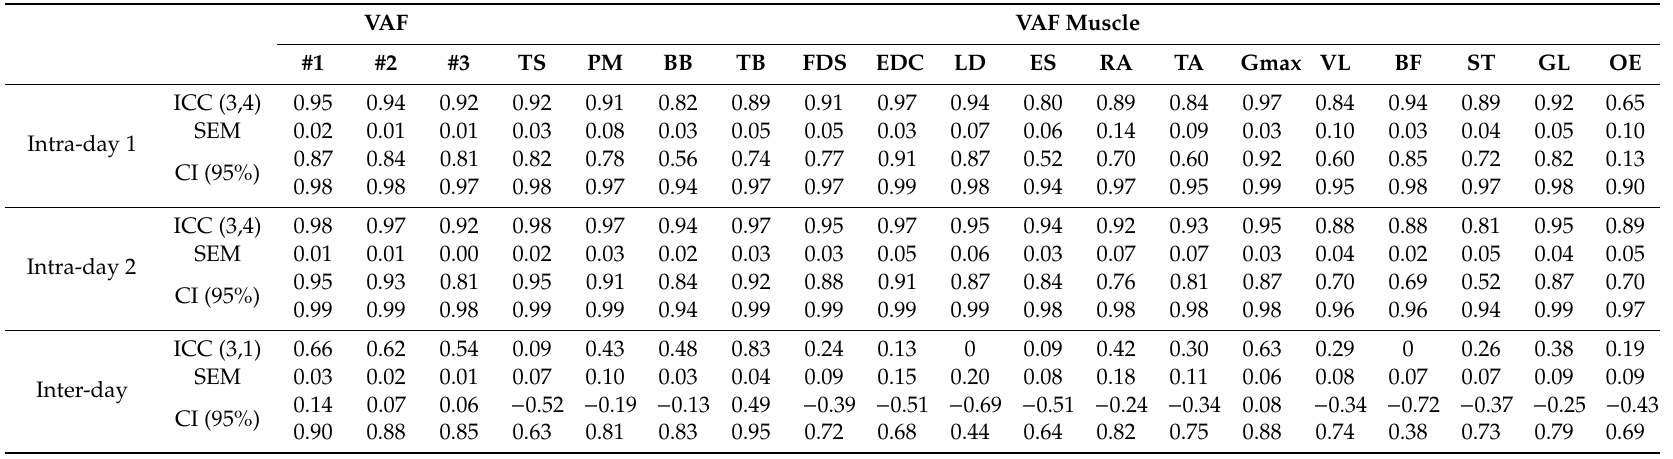
Table 1. Intraclass correlation (ICC), SEM and Confidence Interval (CI (95%)) for of intra- (day 1 and 2) and inter-day reliability analysis of VAF and VAF muscle